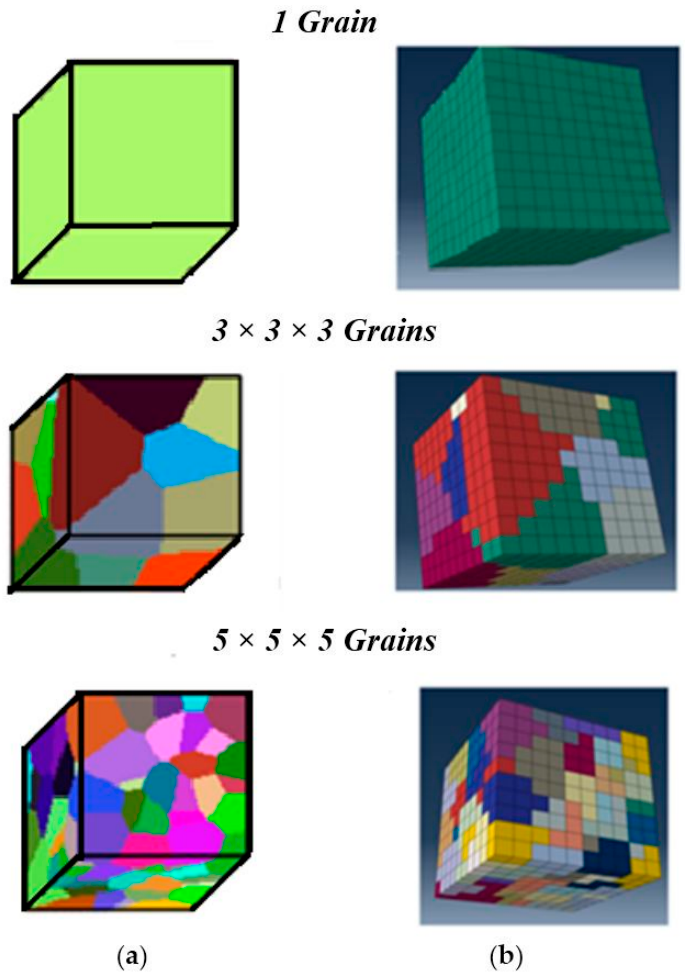
Figure 7. Polycrystal geometry formation through: ( a ) Voronoi tessellations; ( b ) corresponding FEA and GMC discretization.